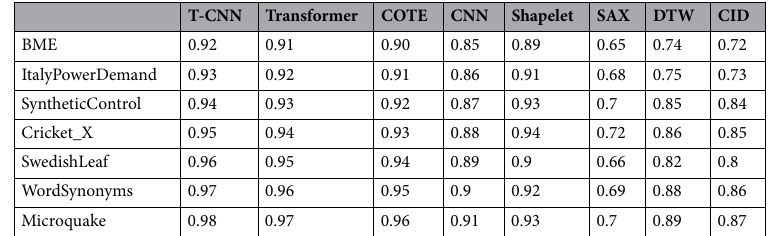
Table 4. Comparison of classification precision table.